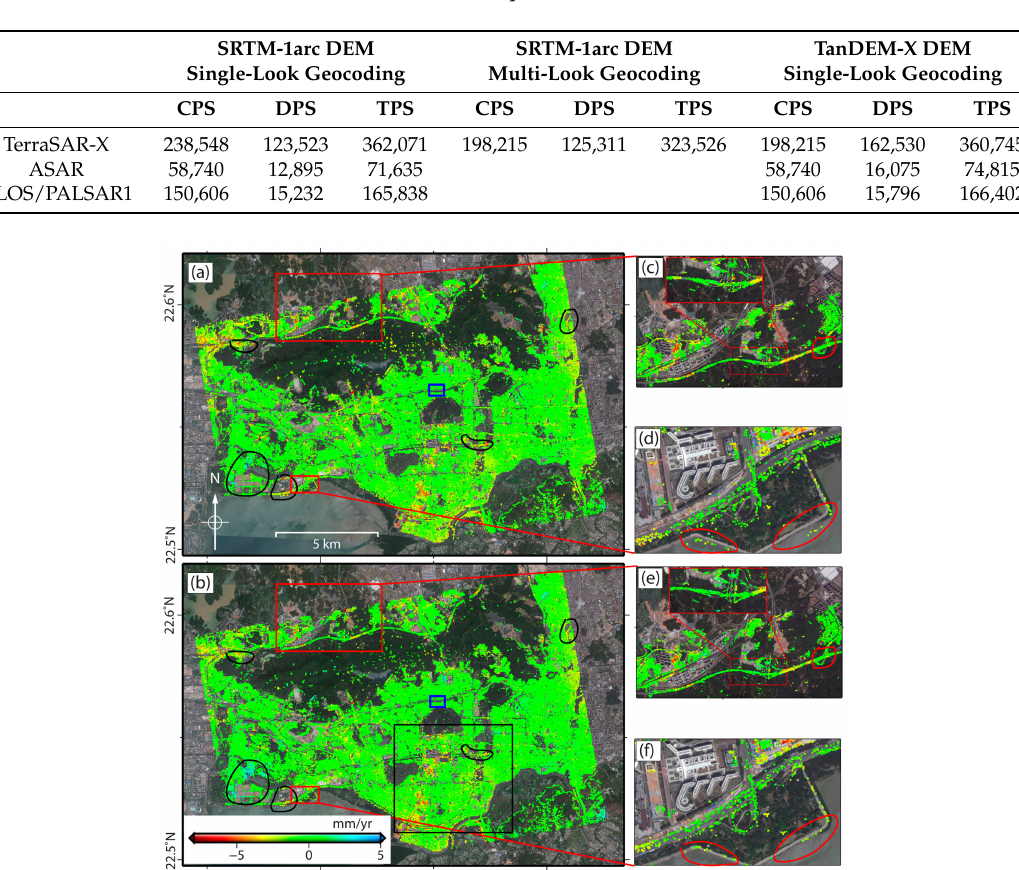
Figure 7. Mean deformation rate maps for X band with different external DEMs: SRTM-1arc DEM ( a ); and TanDEM-X DEM ( b ). ( c – f ) The zoom of the areas outlined by red rectangles in ( a , b ). Areas outlined by black solid lines have obvious deformation rate differences in ( a , b ). The black rectangle in ( b ) is the overlap areas selected for deformation rate comparison of the three platforms. The blue bold rectangles are the reference